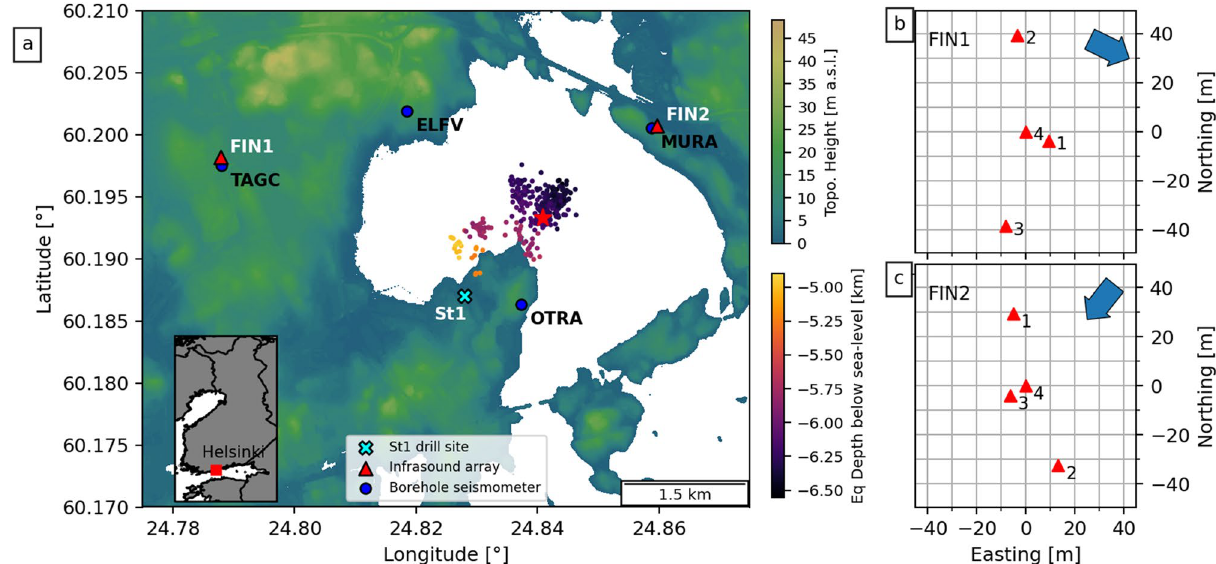
Figure 1. ( a ) Topographic map of the region around the St1 drill site (cyan cross) showing locations and names of borehole seismic stations (blue circles) and temporary acoustic arrays (red triangles). Also plotted are locations of earthquakes recorded during the acoustic deployment, colored by depth. Red star indicates the location of the M w 1.87 event. Inset: Map of Finland showing location of the Helsinki Metropolitan area. Panels ( b , c ) show the infrasound sensor distribution for arrays FIN1 and FIN2, respectively, with back azimuth direction to the ST1 drill site indicated by the blue arrow. Topographic data used in panel ( a ) were downloaded from the National Land Survey of Finland via the Open data file download service (last accessed December 2020). This figure was generated using Matplotlib (v. 3.2.2; matplotlib.org) 31 and Cartopy (v. 0.17.0; scitools.org. uk/cartopy) 32